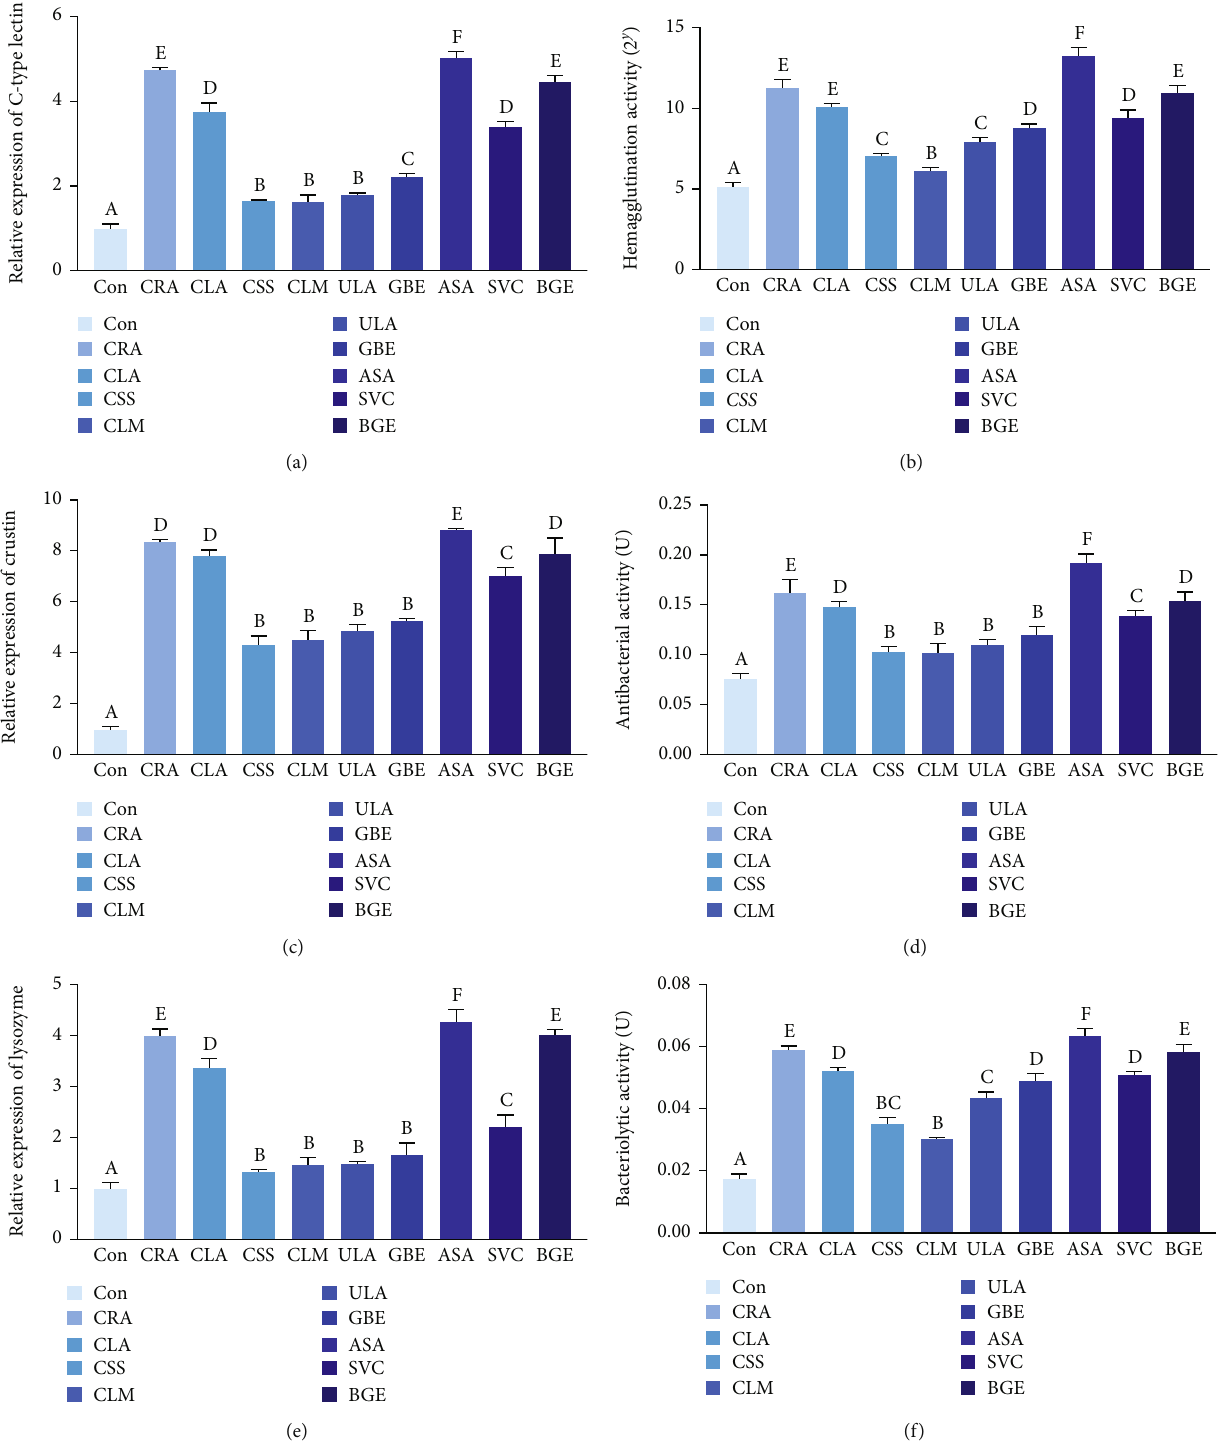
Figure 3: E ff ects of macroalgae diet on the hemagglutination activity, antibacterial activity, and bacteriolytic activity of L. vannamei . Relative expression of C-type lectin (a), hemagglutination activity (b), relative expression of crustin (c), antibacterial activity (d), relative expression of lysozyme (e), and bacteriolytic activity (f) of L. vannamei in di ff erent groups. All data were expressed as mean ± SE ( n = 3 ). The mean column of di ff erent superscript letters (A – F) was signi fi cantly di ff erent ( P < 0 : 05